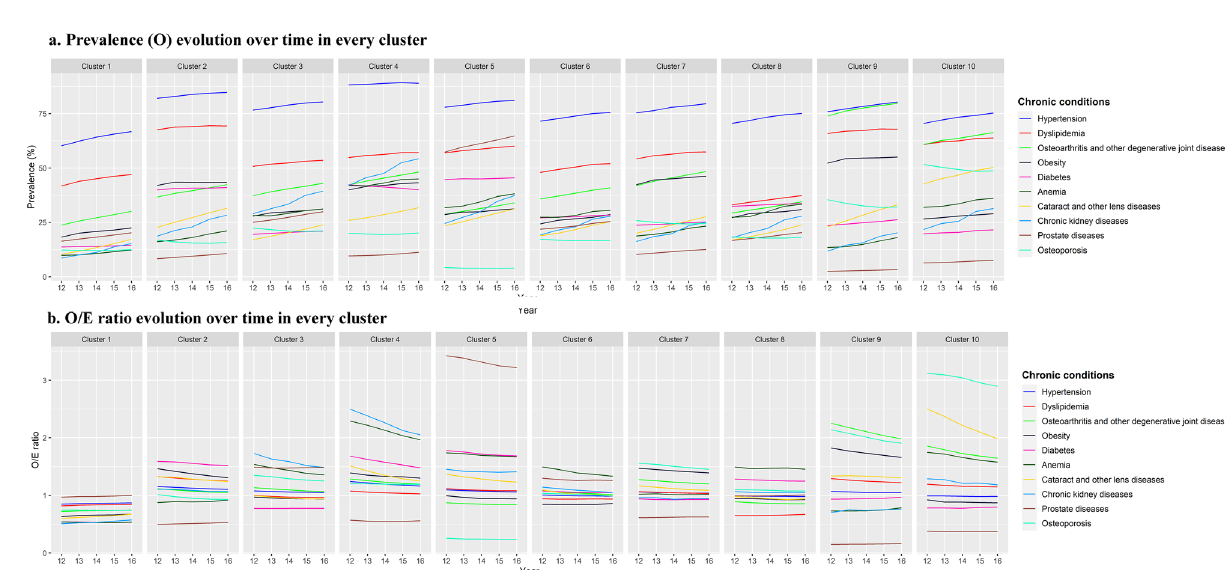
Figure 2. Prevalence and O/E ratio evolution over time in every cluster. ( a ) Prevalence (O) evolution over time in every cluster. ( b ) O/E ratio evolution over time in every